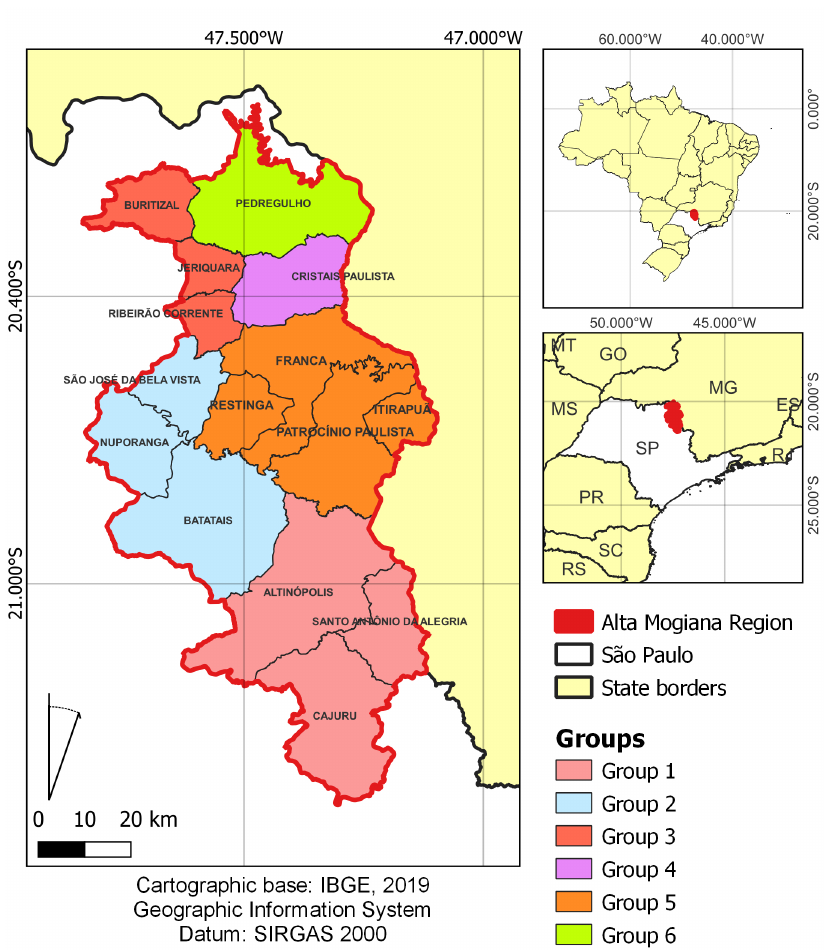
Figure 1. Location of the study area – Alta Mogiana region in the state of São Paulo – Brazil.